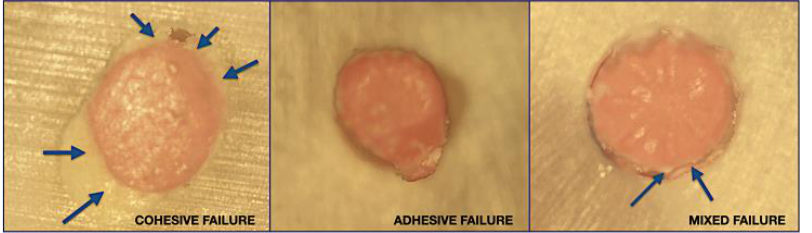
Figure 2. Samples under magnification × 20 as observed just after push-out test illustrating the three possible bond failures. The push out test stops automatically after decohesion of the gutta-percha cone. The latter is nevertheless still visible on the pictures due to its incomplete dislodgment. The blue arrows indicate some areas showing the sealer.